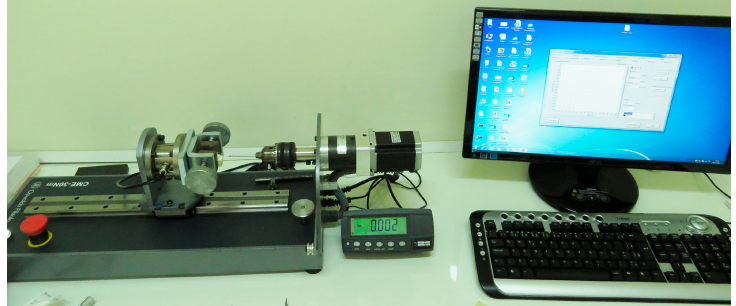
Figure 7. Image of the torque machine used for the torque removal measurements.